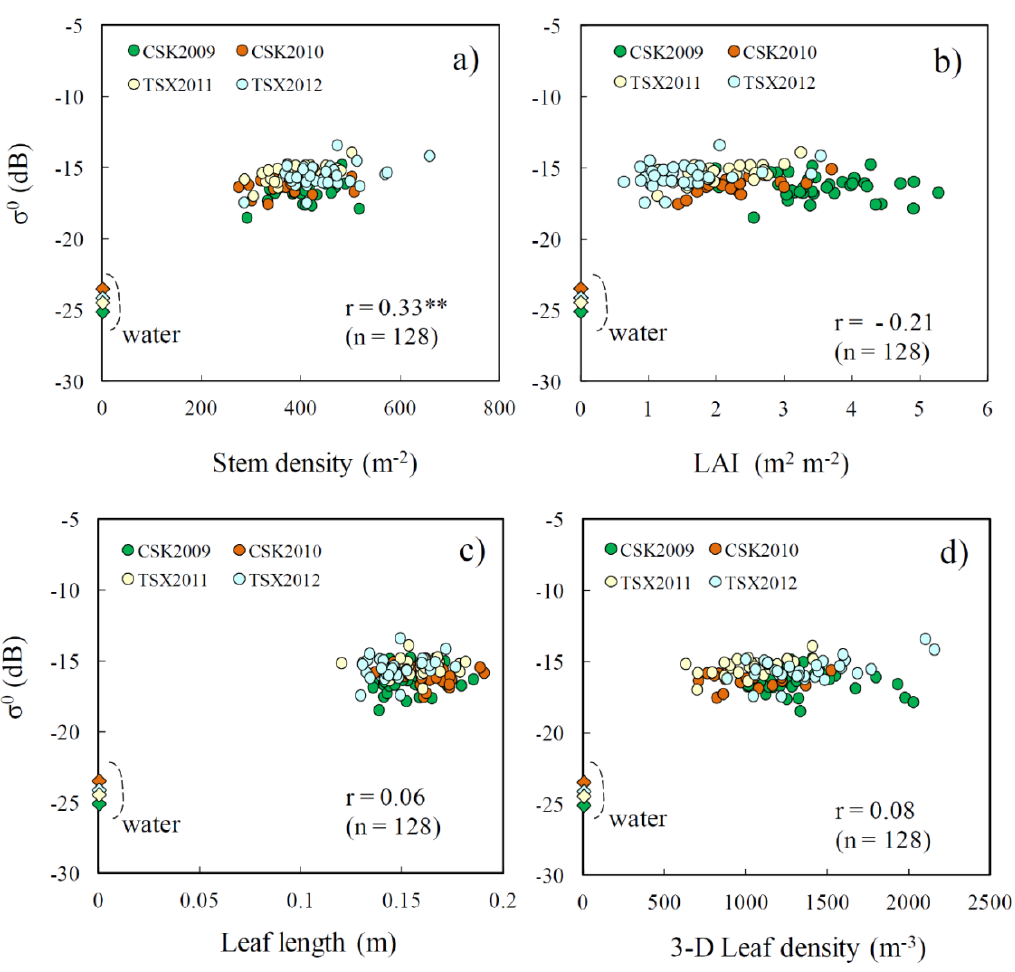
Figure 7. Relationships of X-VV σ 0 with ( a ) stem density; ( b ) LAI; ( c ) leaf length; and ( d ) 3-D leaf density. Combined data from the two sensors after offset correction were used. The σ 0 values for the water surfaces are given on the y-axis for reference. ** indicate the statistical significance at